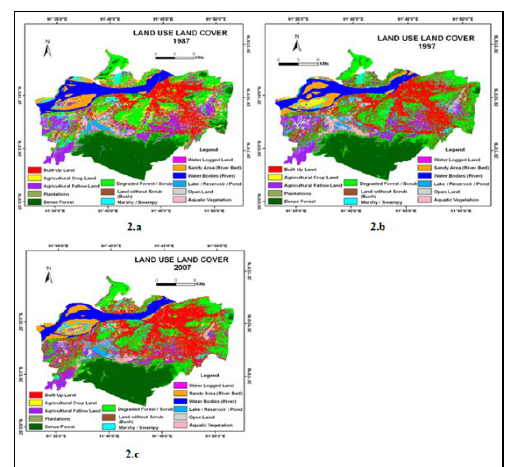
Figure 2: Classified Land Use Land Cover Map of 1987, 1997 and 2007